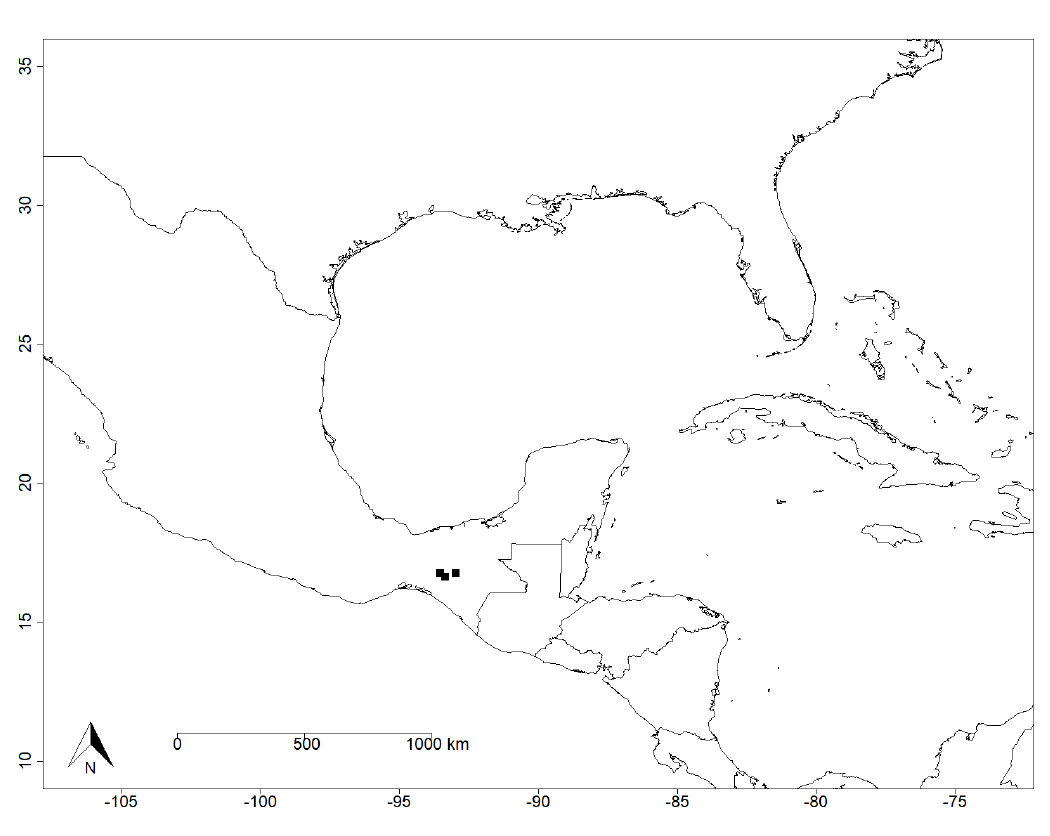
Fig. 4. Distribution map showing the localities (black squares) of Croton calcareus Riina & Mateo- Ram. sp. nov., all known from southern